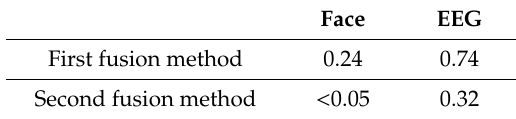
Table 9. The results of statistical tests in the online experiment in arousal